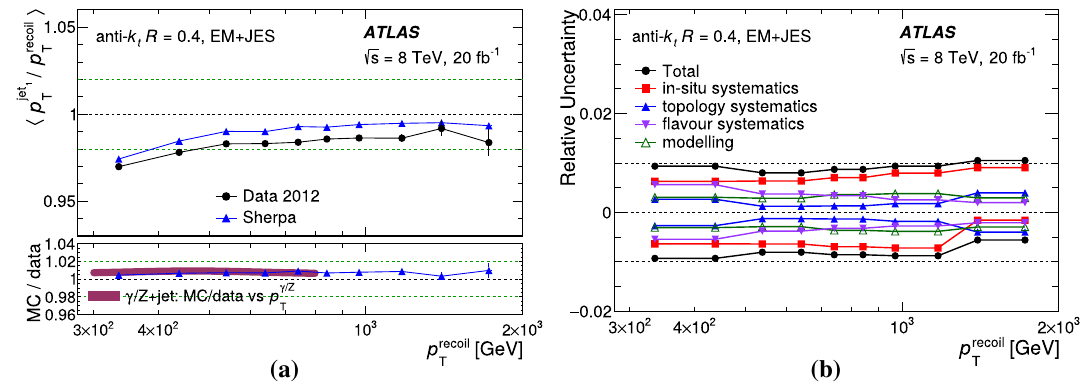
Fig. 37 a Multijet balance R MJB in data (circles) and MC simula- tion (triangles) for anti- k t R = 0 . 4 jets calibrated with the EM+JES scheme. The bottom frame compares R MC corresponding γ /Z+jet results (magenta solid line). b The impact of